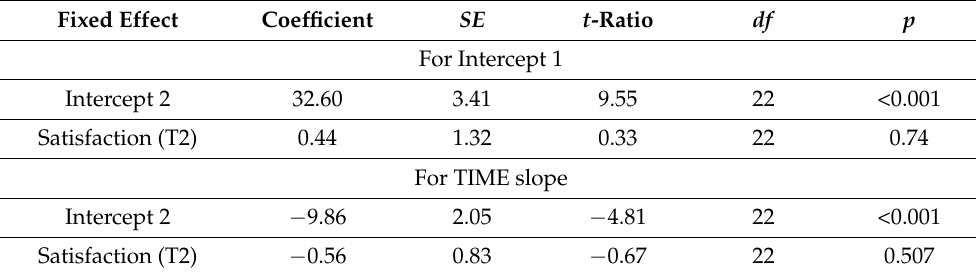
Table 3. Final estimation of fixed effects; Predicting Change in Satisfaction.